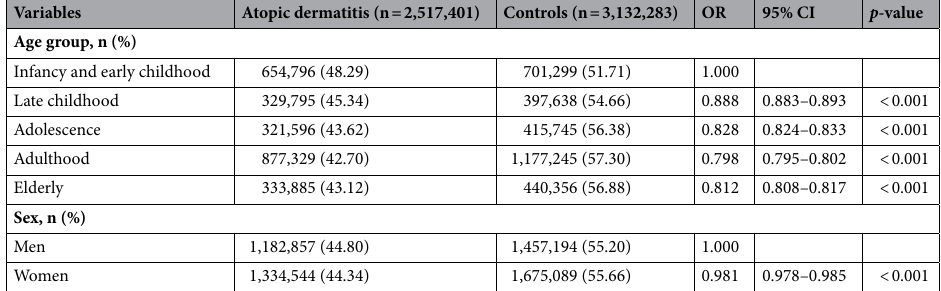
Table 1. Baseline characteristics of patients with AD and control group. Baseline characteristics of patients in the AD and control group. All personnel in this study were Koreans. The p -value was obtained through the chi- square test. CI confidence interval.